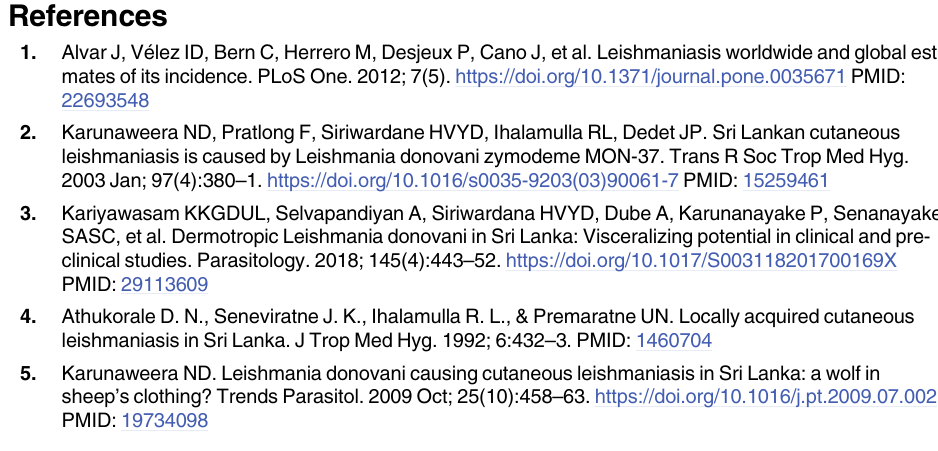
S1 Table. Binary logistic regression conducted with varying conditions and the respective